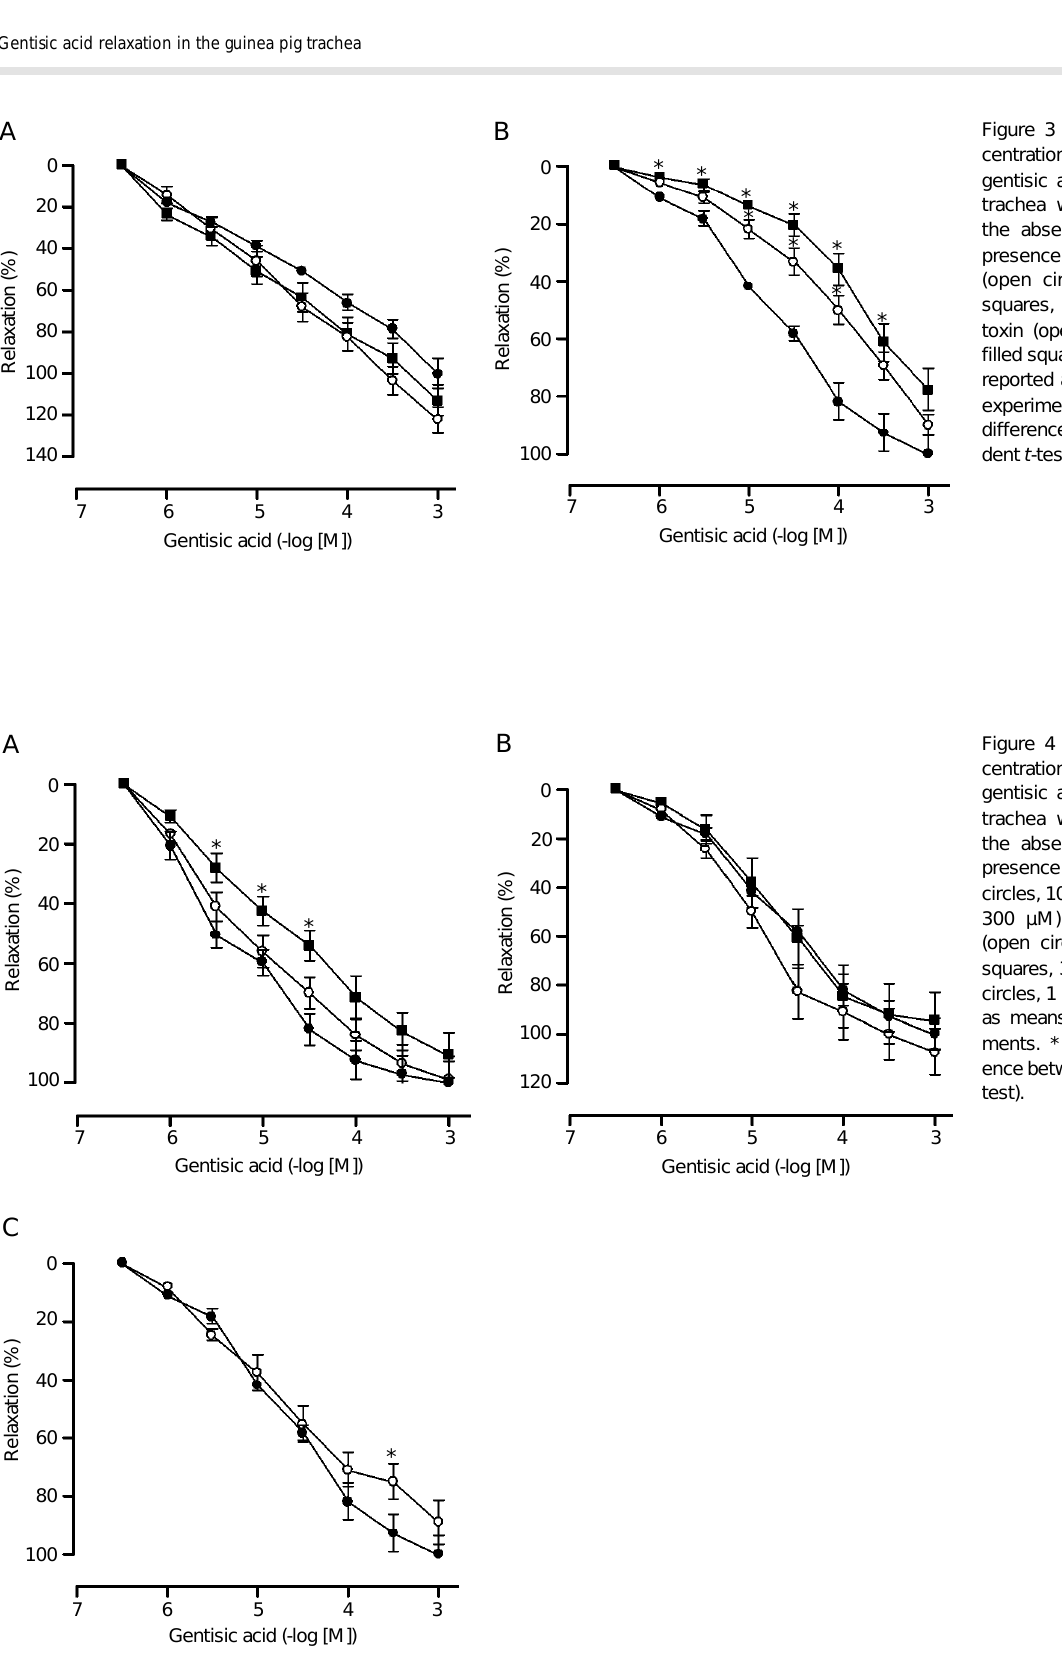
Figure 4 - Mean relaxant con- centration-response curves for gentisic acid in the guinea pig trachea without epithelium in the absence (filled circles) or presence of: A , L-NOARG (open circles, 100 µM or filled squares, 300 µM); B , methylene blue (open circles, 10 µM or filled squares, 30 µM); C , ODQ (open circles, 1 µM). Data are reported as means ± SEM of 6 experi- ments. *P<0.05 for the differ- ence between points (Student t -